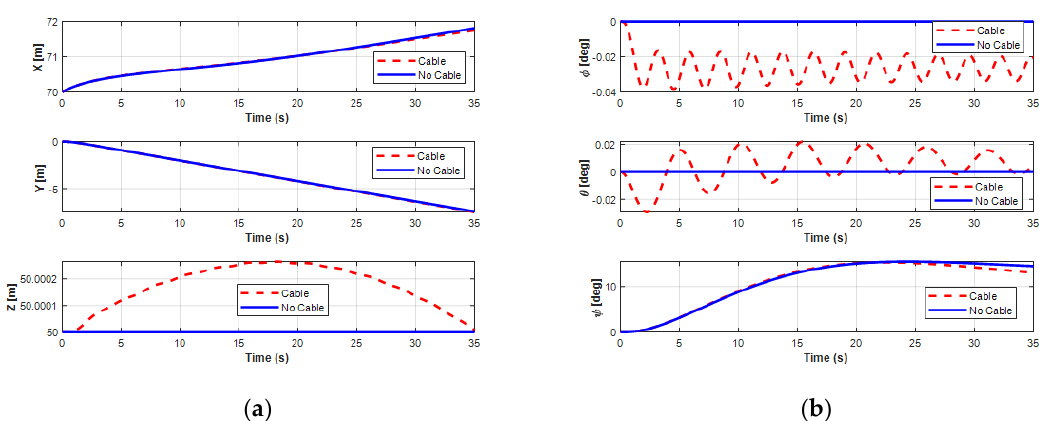
Figure 30. Simulation results of position and orientation of the UUV doing the sideward motion: ( a ) position of the UUV; ( b ) orientation of the UUV.